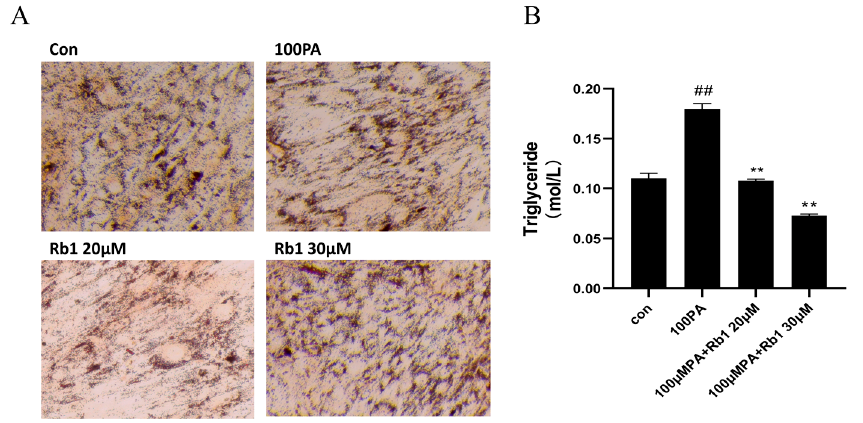
Figure 4. ADSC cell morphology (20 × ) ( A ) and triglyceride content in cells ( B ) at different concen- trations (## p < 0.01 significantly compared with Con group; ** p < 0.01 significantly compared with 100 PA group).